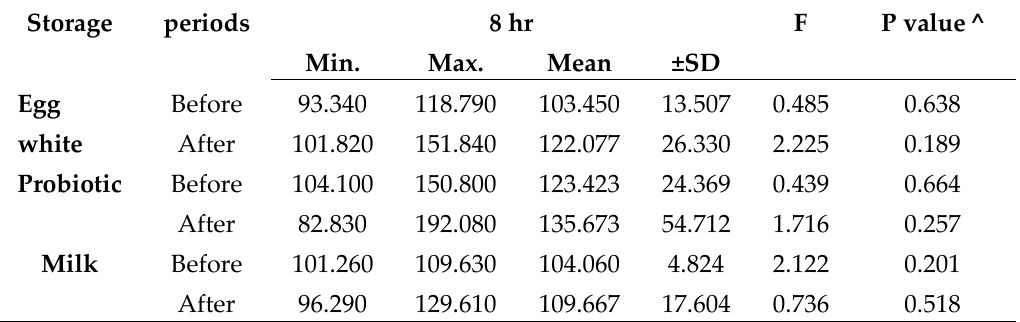
Table 6 : Descriptive and statistical test of granularity diameter among periods by storage media Storage